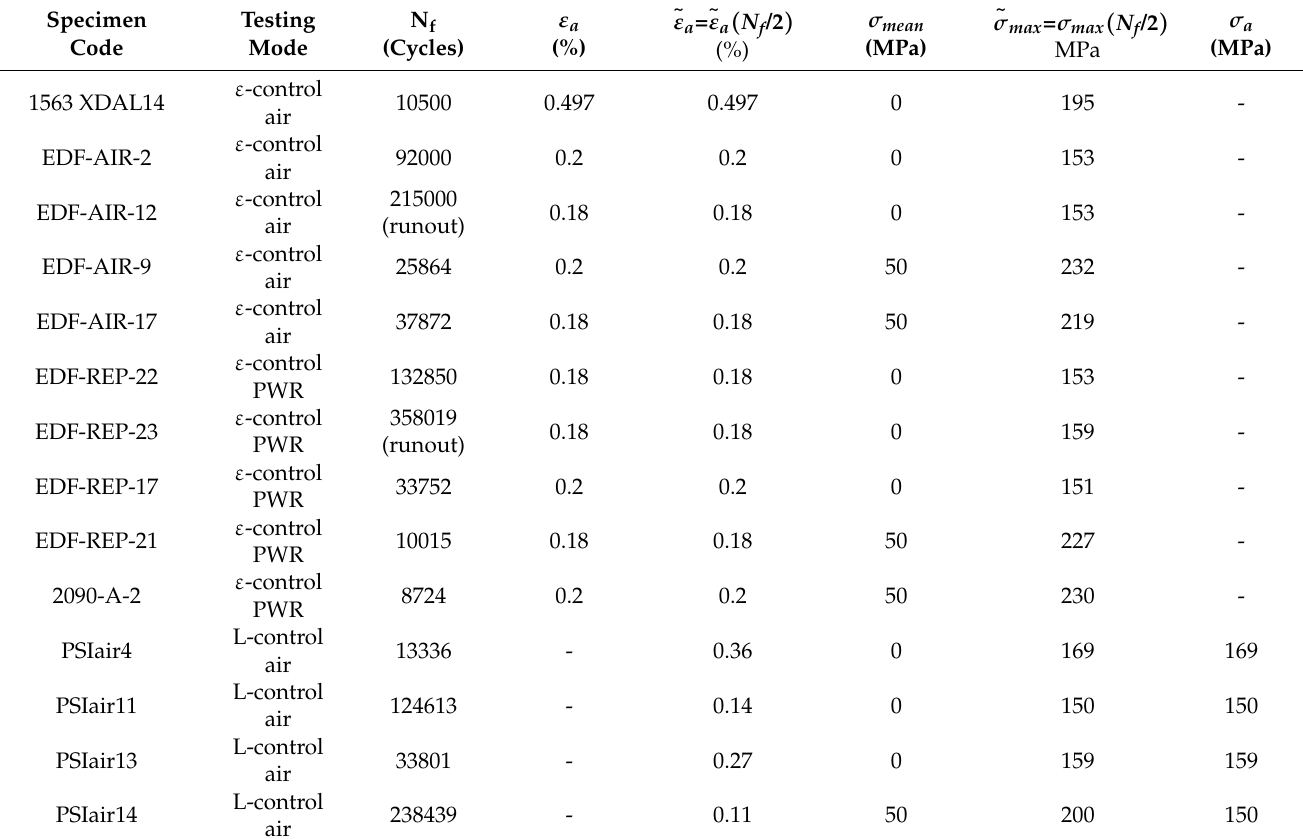
Table A1. Fatigue data of the INCEFA-PLUS mean stress program obtained with different control modes and mean stresses. Specimen